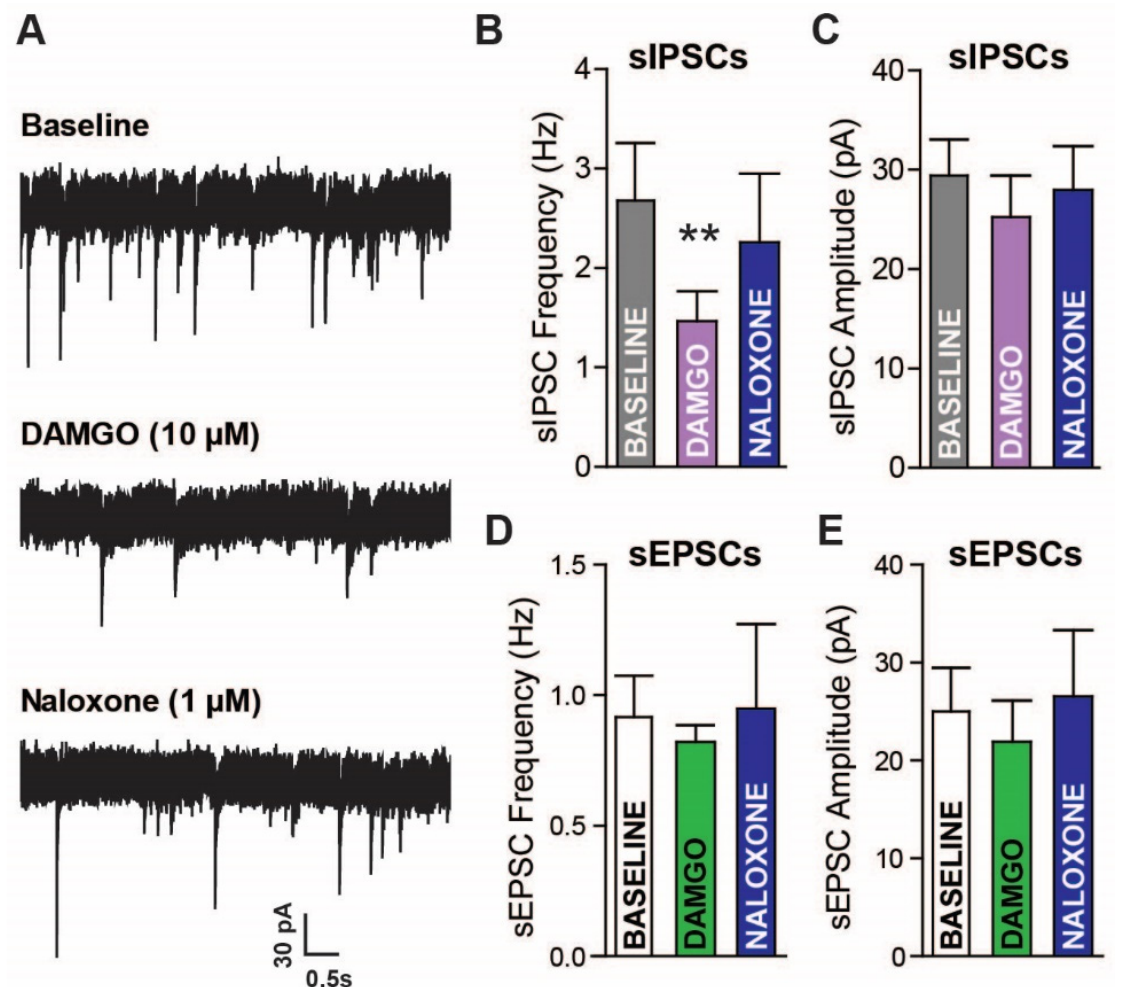
Figure 3. Acute mu-opioid (MOR) activation reduces GABAergic but not glutamatergic currents in amygdala lateral paracapsular (LPC) neurons. ( A ) raw spontaneous inhibitory postsynaptic cur- rents (sIPSCs) recorded during artificial cerebrospinal fluid (aCSF) (baseline), DAMGO (10 µM), and naloxone (1 µM) application. Whole cell voltage-clamp electrophysiology was used to measure the frequency ( B ) and amplitude ( C ) of currents in LPC neurons. sIPSC frequency was reduced by MOR activation, which reversed with MOR antagonism. sEPSCs were also recorded in LPC neu- rons, with no clear effects of MOR activation/inactivation on sEPSC ( D ) frequency and ( E ) ampli- tude. Baseline vs. DAMGO ** p < 0.01.